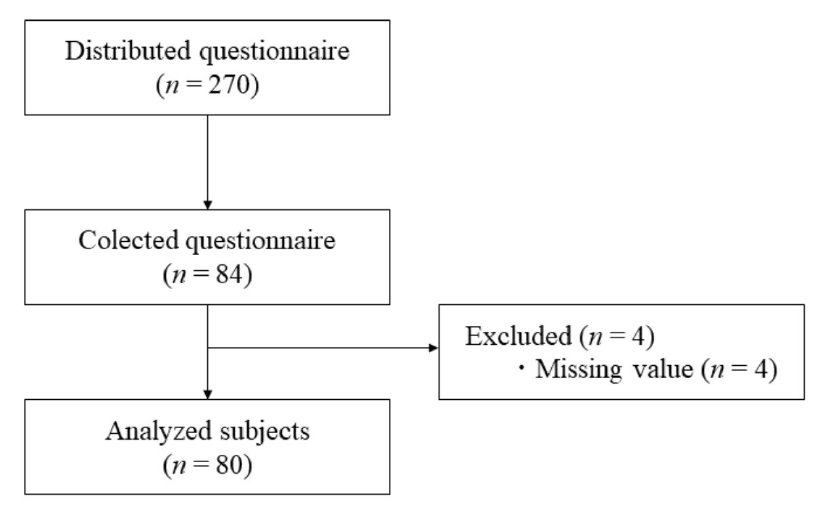
Figure 1. Flow chart of data collecting